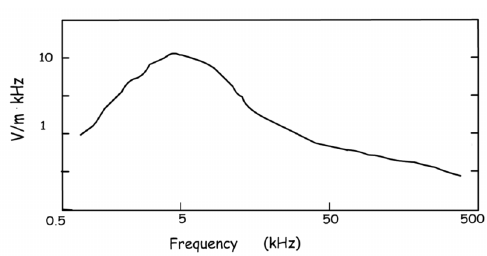
Fig. 2. Lightning frequency domain electromagnet- ic